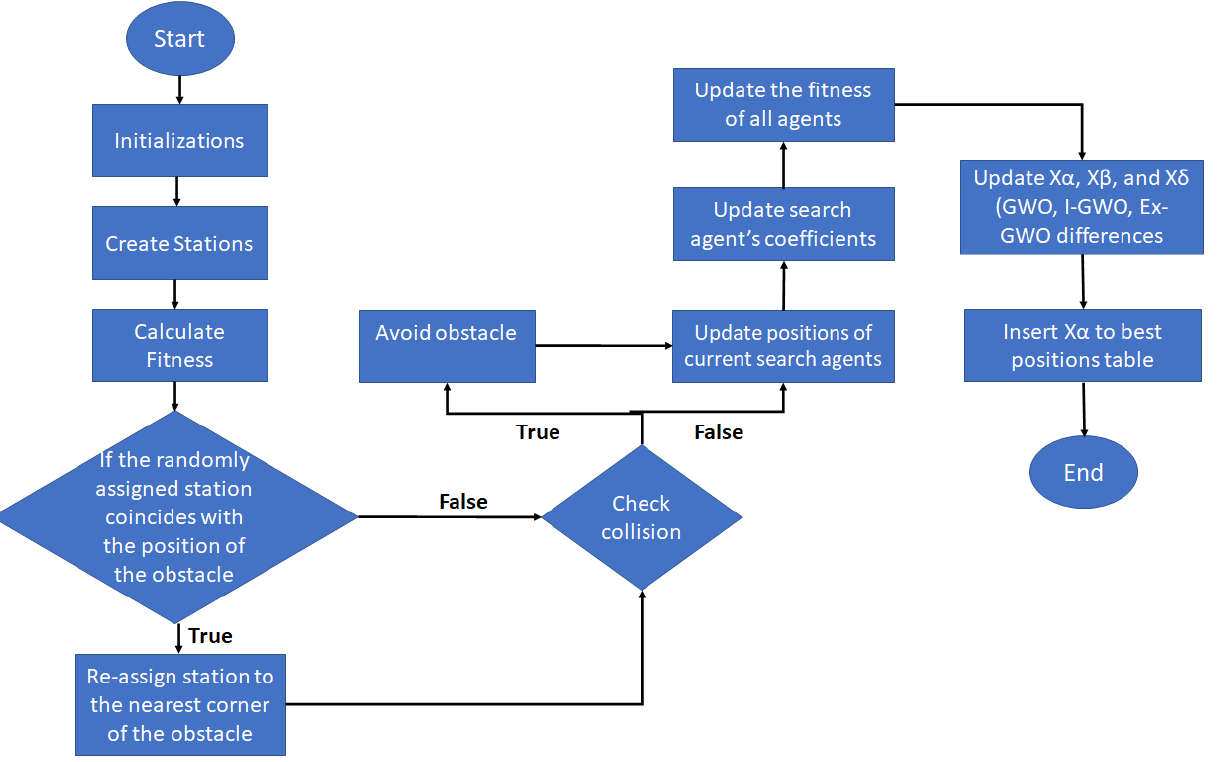
Figure 6. Proposed path planning method flowchart.